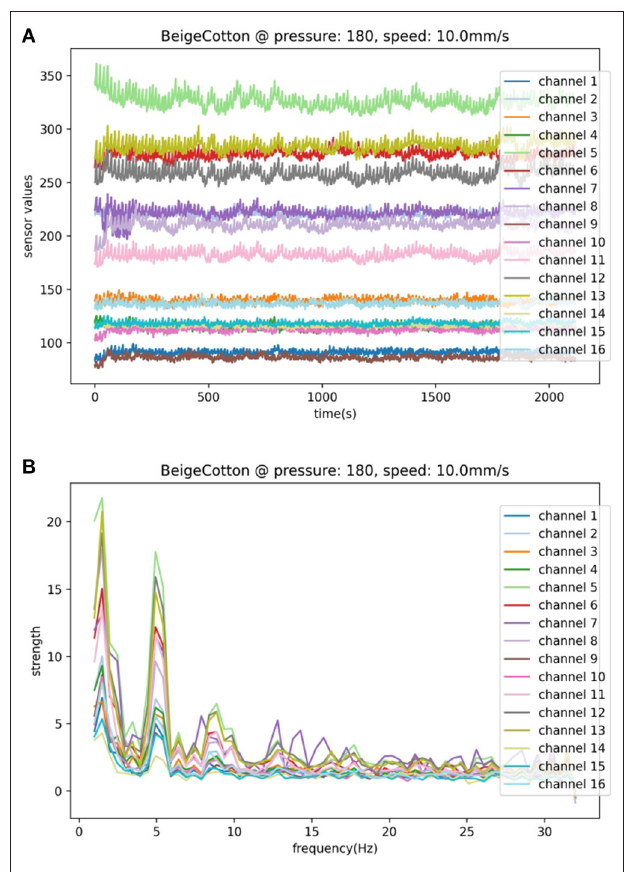
FIGURE 3 | A sample of the multichannel tactile signals in (A) space domain and (B) frequency domain.